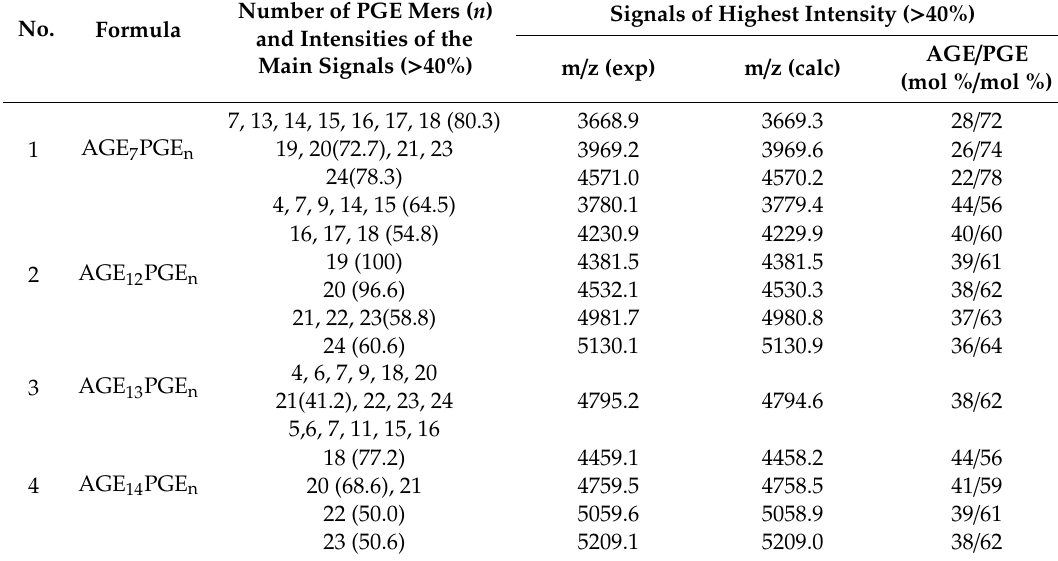
Table 11. Composition of AGE/PGE random copolyether–diol determined by MALDI-TOF mass spectrometry.